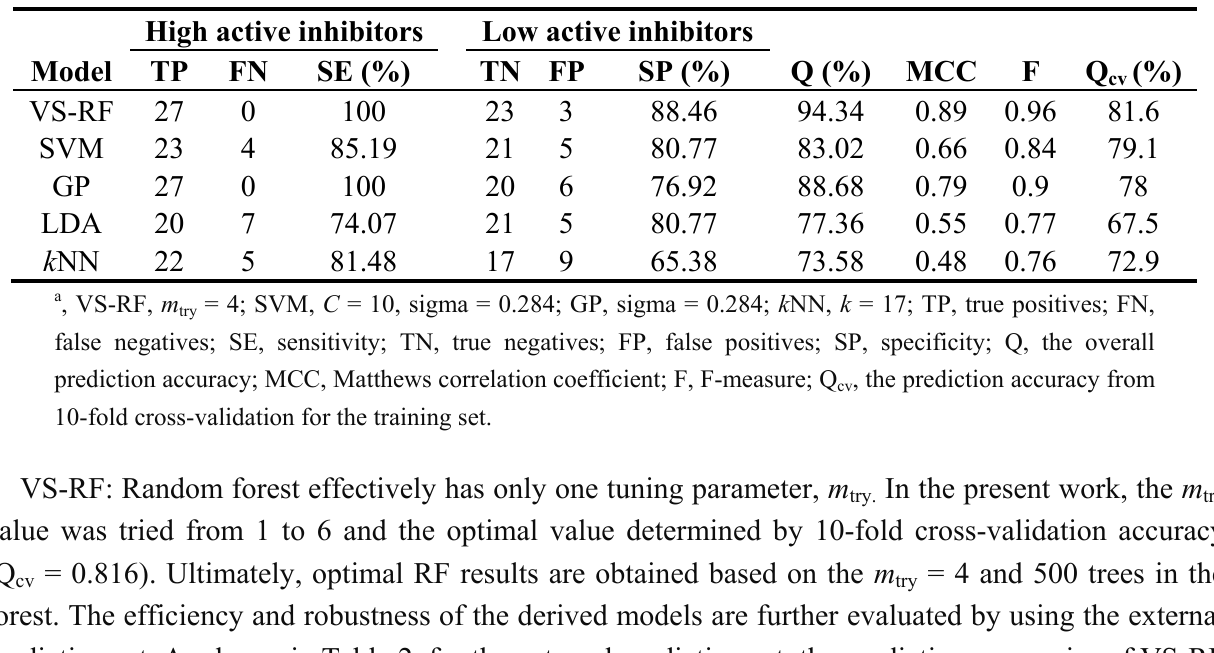
Table 2. The prediction performance of high and low active compounds as respiratory syncytial virus (RSV) inhibitors from VS-RF, SVM, GP, LDA and k NN statistical methods for the external prediction set and the 10-fold cross-validation a